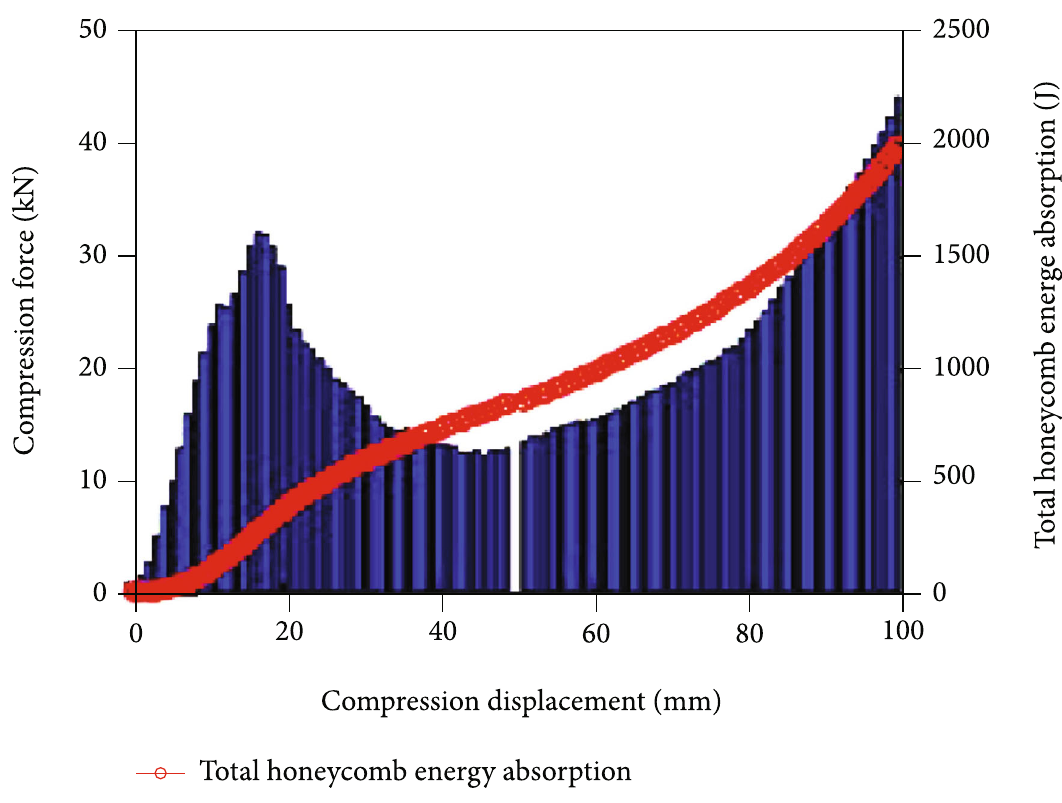
Figure 13: Honeycomb energy absorption curve when compressed on di ff erent